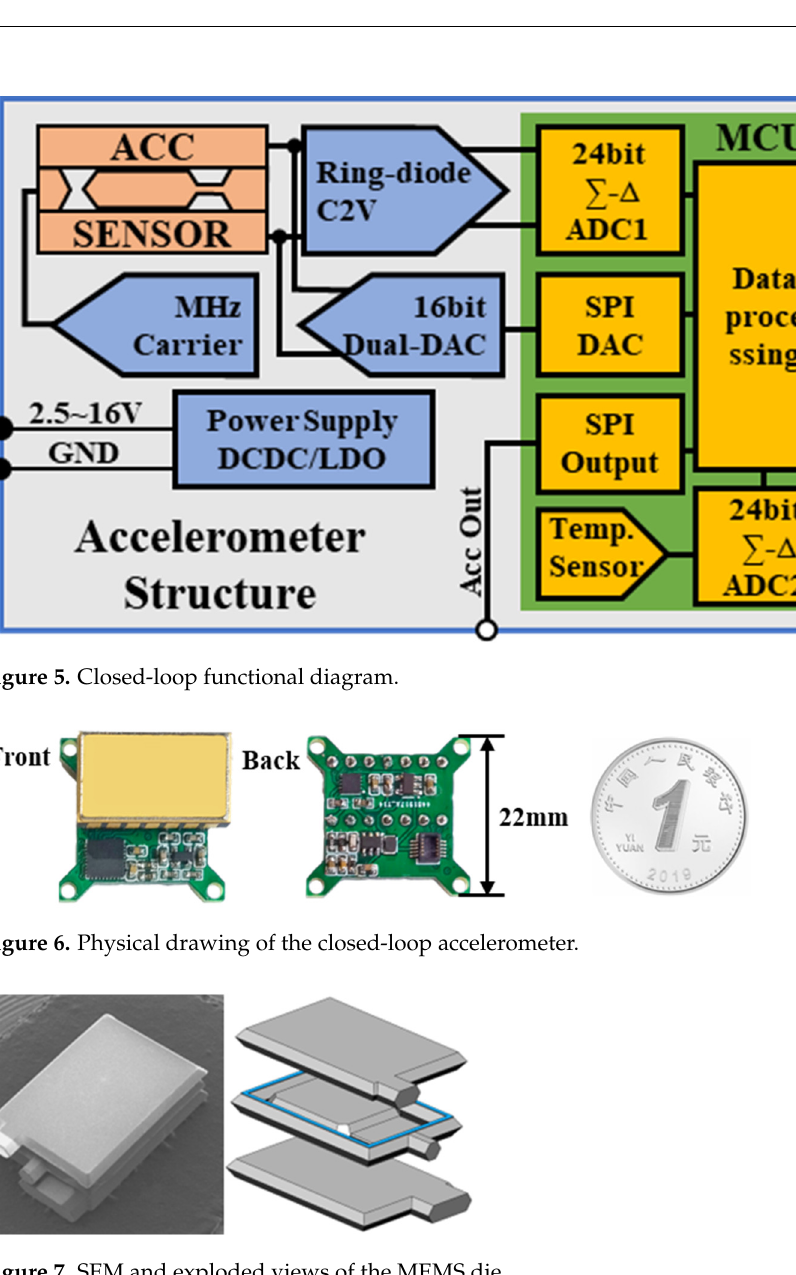
Figure 7. SEM and exploded views of the MEMS